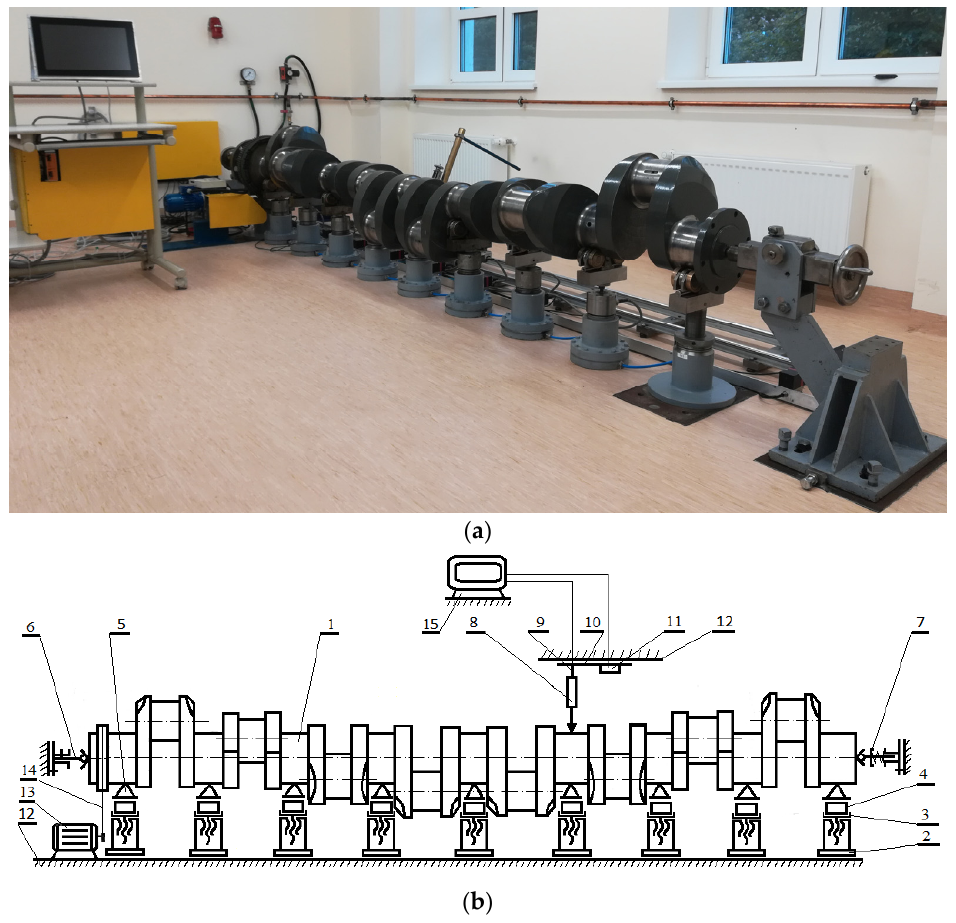
Figure 10. Test stand equipped with a system of supports with the possibility of their height positioning ( a ), diagram of the most important elements of the test stand ( b ) (1—crankshaft, 2—